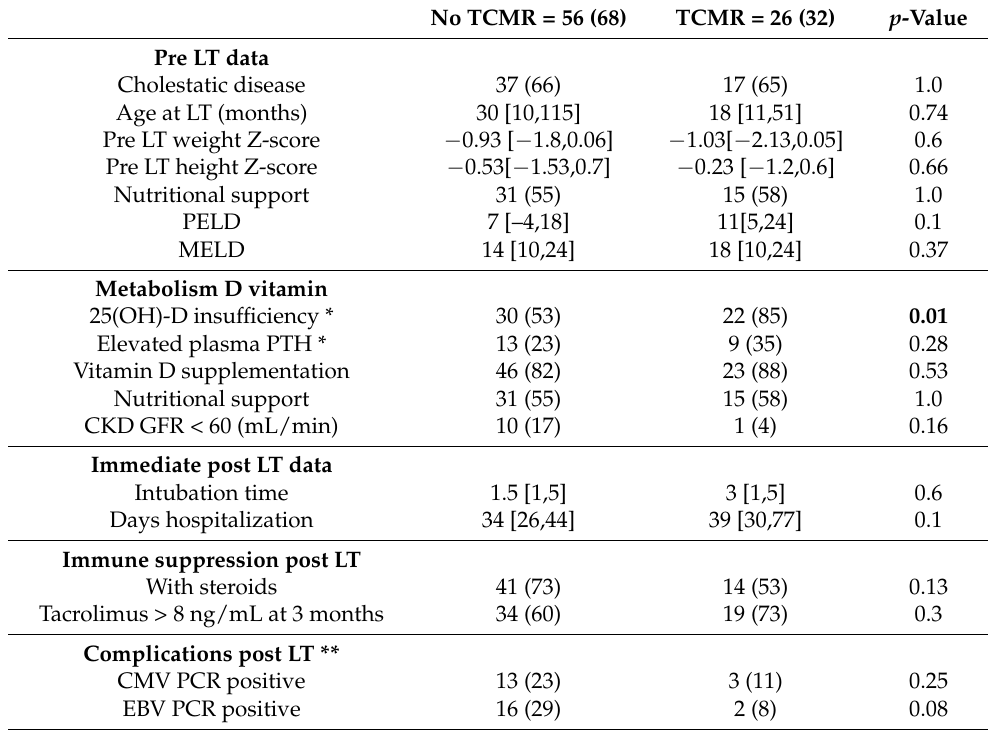
Table 2. Comparison between group with and without TCMR.